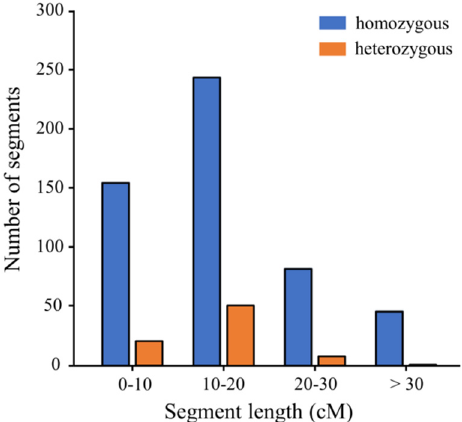
Figure 2. Distribution of the lengths of substituted chromosome segments in the chromosome segment substitution line population.